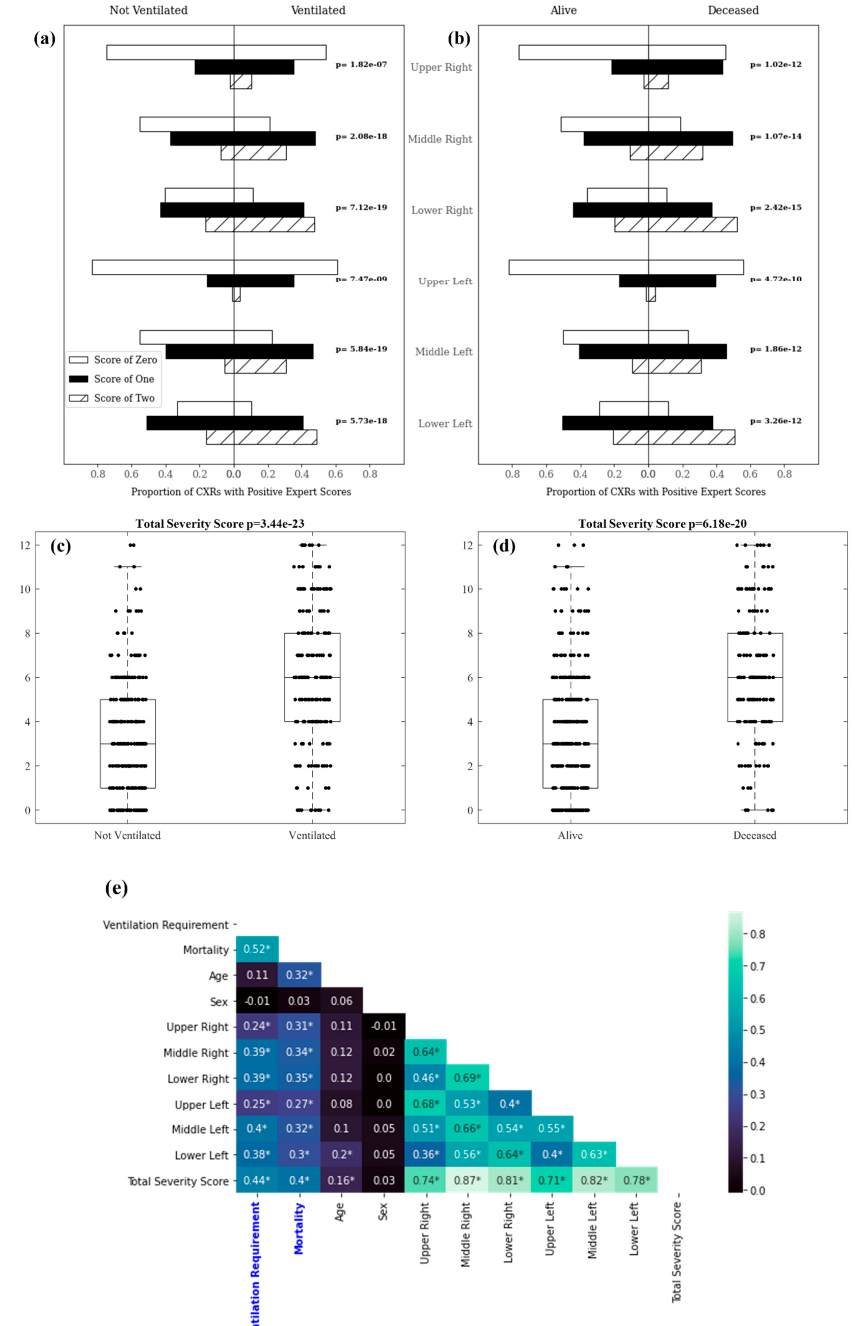
Figure 7. Zone-wise expert scores distribution: ( a ) and ( b ) depict the proportion of patients whose CXRs had lung zone scores of 0, 1, and 2 in each pictured population; ( c ) and ( d ) visualize the distribution of total zone-wise scores assigned to CXRs for patients in each population; ( e ) displays correlations between zone-wise severity scores and clinical outcomes. Asterisks denote statistical significance at the level of p = 0.01 as determined by a Pearson’s correlation